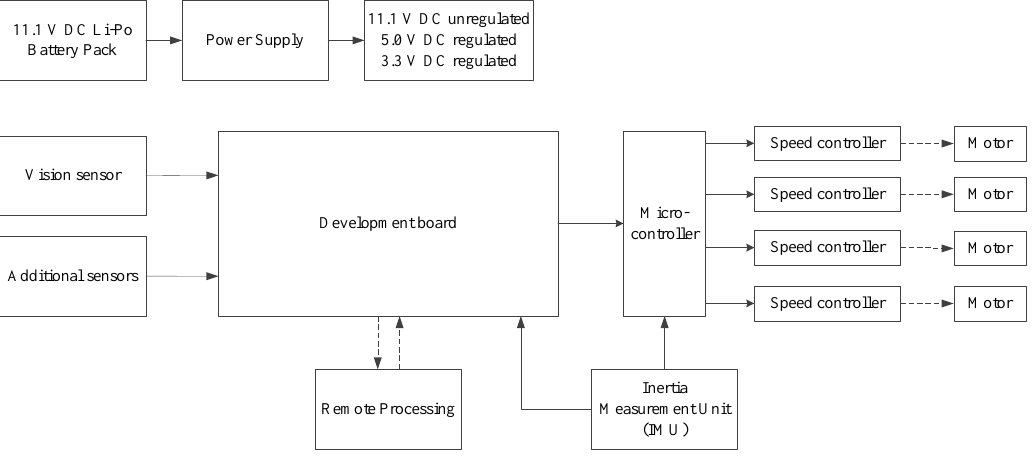
Figure 4. Electrical structure of an